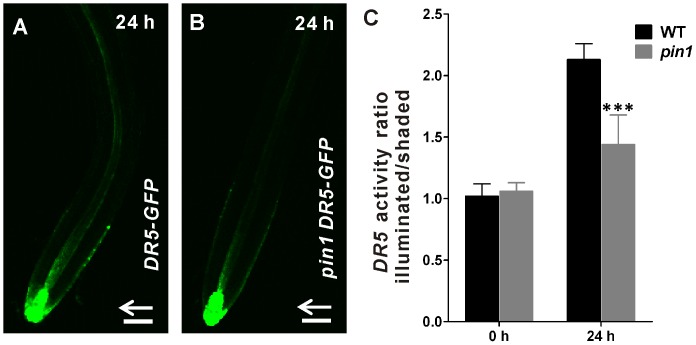
PIN1 activity is needed for asymmetric auxin distribution in root negative phototropism.(A–B) DR5 activity was monitored in the DR5REV::GFP (A) and pin1 DR5REV::GFP (B) seedlings exposed to unilateral blue light illumination (10 µmol m−2sec−1) for 24 h. Arrows indicate blue light direction. Bars = 50 µm. (C) GFP signal intensities in (A–B) were quantified and their ratios at the illuminated side versus the shaded side are presented in (C). At least twelve seedlings were imaged per line for each of three replicates. Error bars represent standard deviation and *** indicate significant difference at P<0.001, as determined by Student’s t-test.